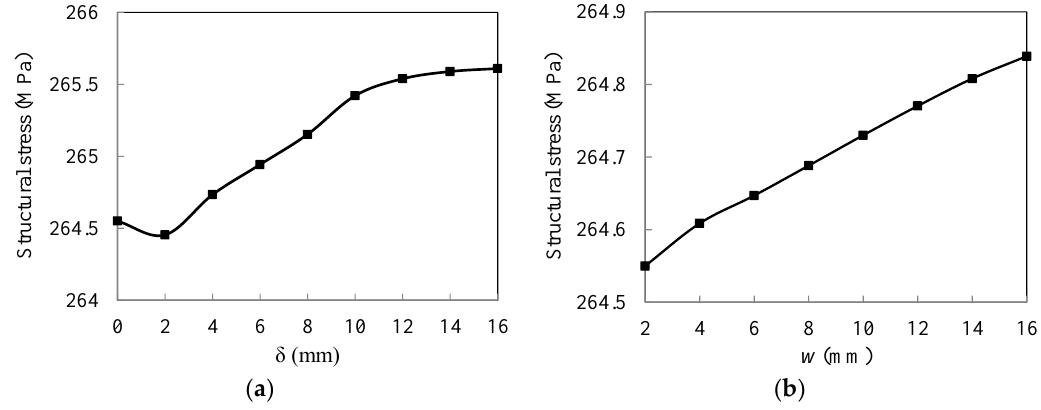
w . ( a ) The parameter  (